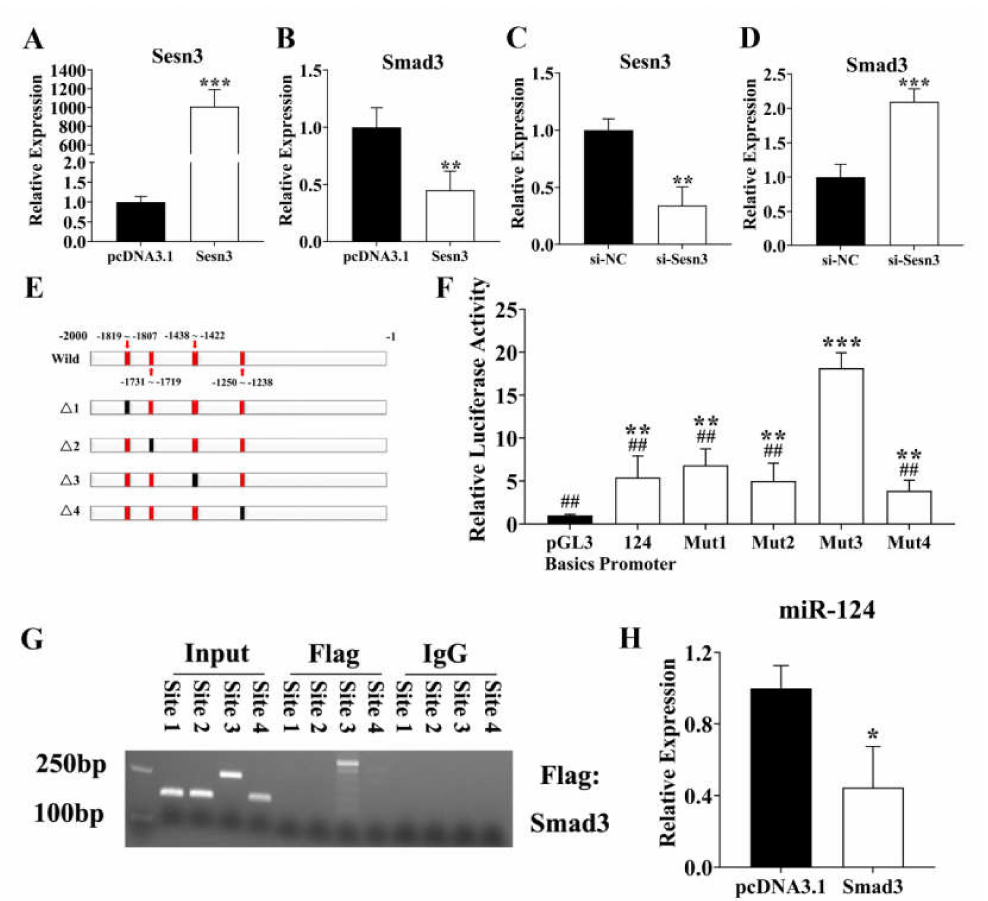
Figure 3. SMAD3 suppressed ssc-miR-124 transcription by binding to its promoter. ( A , B ) Rela- tive expression of Sesn3 and Smad3 after transfecting pcDNA3.1-Sesn3-CDS into pre-adipocyte. ( C , D ) Relative repression of Sesn3 and Smad3 after transfecting si-Sesn3 into pre-adipocyte. ( E ) The schematic diagram of SMAD3 binding sites in ssc-miR-124 promoter. The red box meant wild binding sites, and black boxes were mutated ones. ( F ) Relative luciferase activity analysis in pre-adipocytes af- ter pGL3 basic vector that contained the sequence with wild binding site or mutated one transfection. ( G ) ChIP-PCR detection of the binding of SMAD3 in ssc-miR-124 promoter region. ( H ) The miRNA real-time PCR analysis of ssc-miR-124 expression level in pre-adipocyte after transfecting pcDNA3.1- Smad3-CDS for 48 h. Data are presented as mean ± s.e.m. * means P < 0.05, ** means P < 0.01, and *** means P < 0.001, which shows the data compared with the control group, ## represented significant difference between promoter Mut3 and other five groups, and means P <